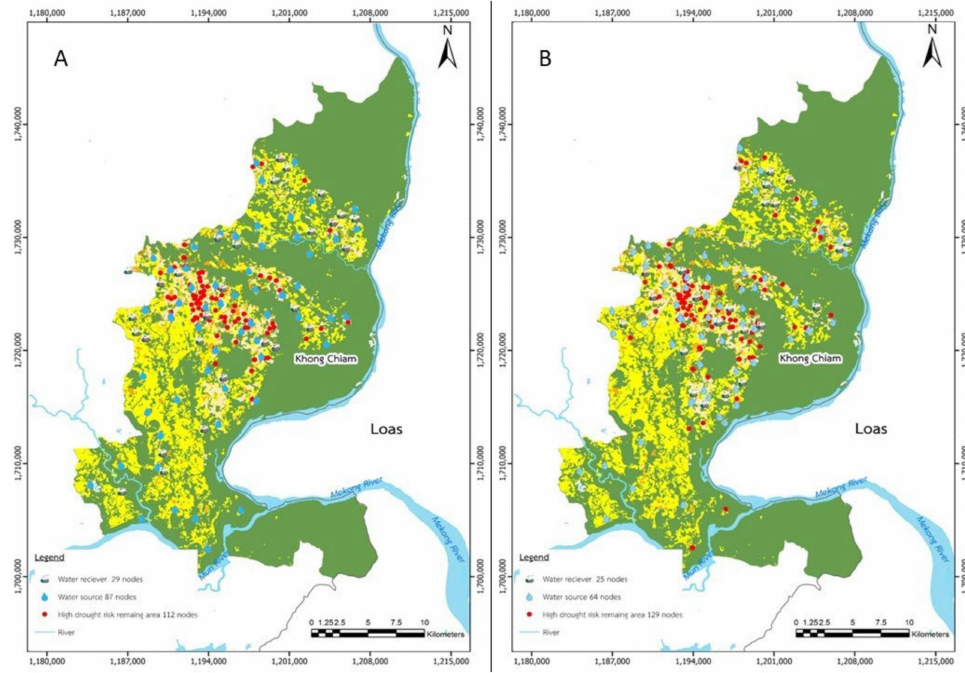
Figure 9. Comparison of risk area in Khong Chiam with construction costs increased by ( A ) 0% and ( B )